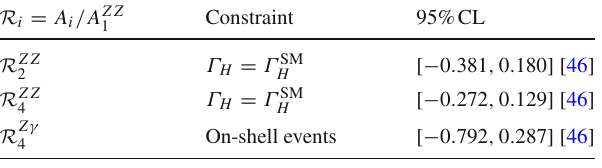
Table 2 Summary of CMS shape measurements on ratios of anoma- lous HVV couplings [45,46]. In the middle column we indicate the assumptions on the Higgs total width